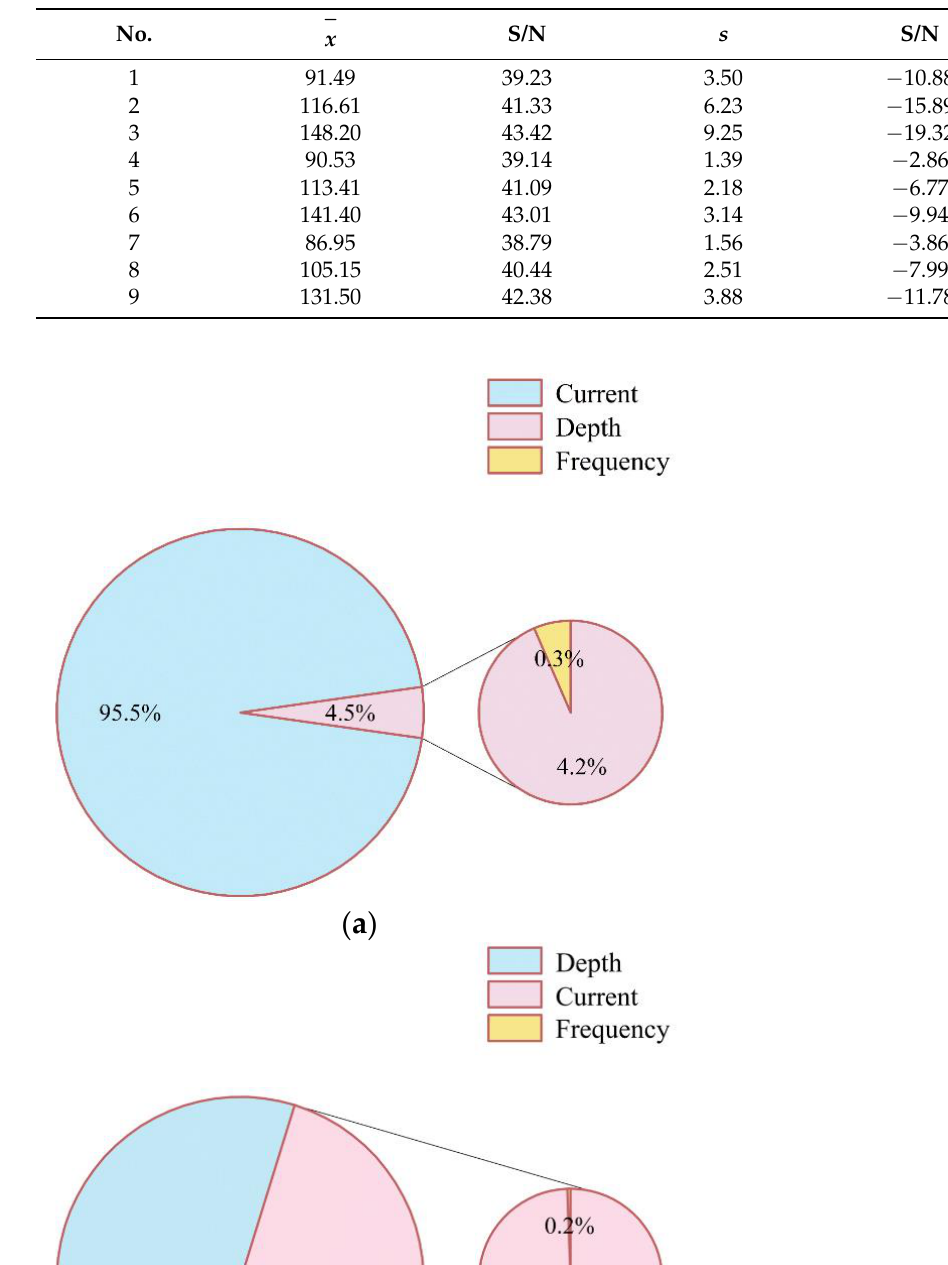
Table 5. Simulation results and S/N ratios.